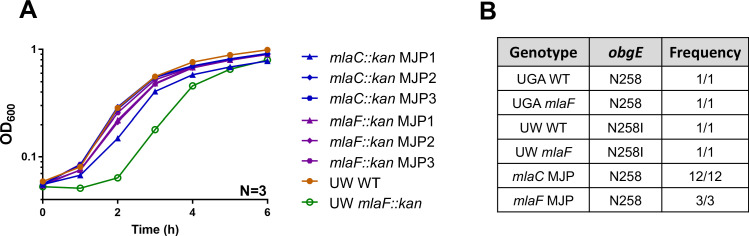
obgE* alleles are selected against in the absence of Mla.(A) Growth curves of ΔmlaC (blue) or ΔmlaF (green) mutants generated in the UW WT. Any strains generated by our hands in this background are annotated with MJPX, with X indicating an independently generated clone. For comparison, the UW WT and UW ΔmlaF provided to us are displayed as black and orange circles respectively. Growth curves were performed in biological triplicate. (B) Table displaying frequency of obgE* to obgE reversion. Both UGA strains contain the WT N258 allele. Both UW strains contain the obgE* allele of N258I. When ΔmlaC strains were generated in the UW WT, obgE* reverted to obgE 12/12 times tested. When ΔmlaF strains were generated in the UW WT, obgE* reverted to obgE 3/3 times tested. SNP presence was determined by sanger sequencing.